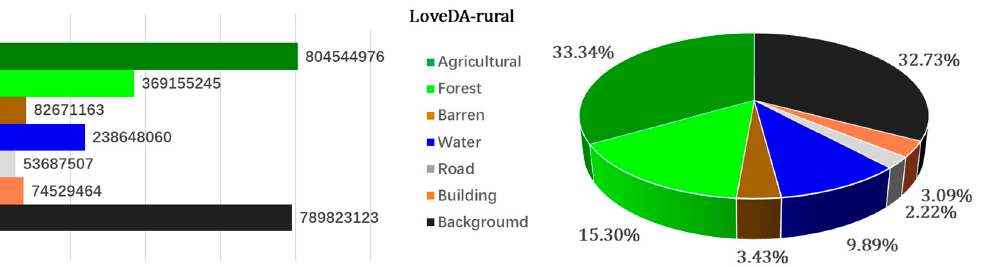
Figure 1. Number and percentage of pixels in each classification sample in the LoveDA-rural dataset.